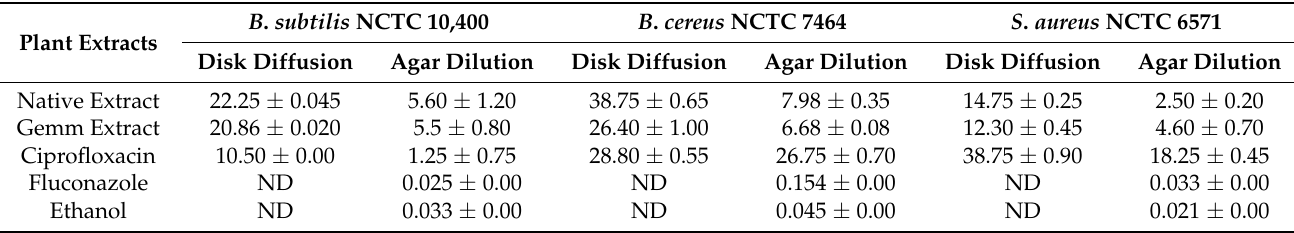
Table 2. Antimicrobial activity of native and gemm extracts of H . griffithi expressed as MIC ( µ g/mL) determined by disk diffusion and agar dilution methods against Gram-positive bacterial strains. Plant Extracts